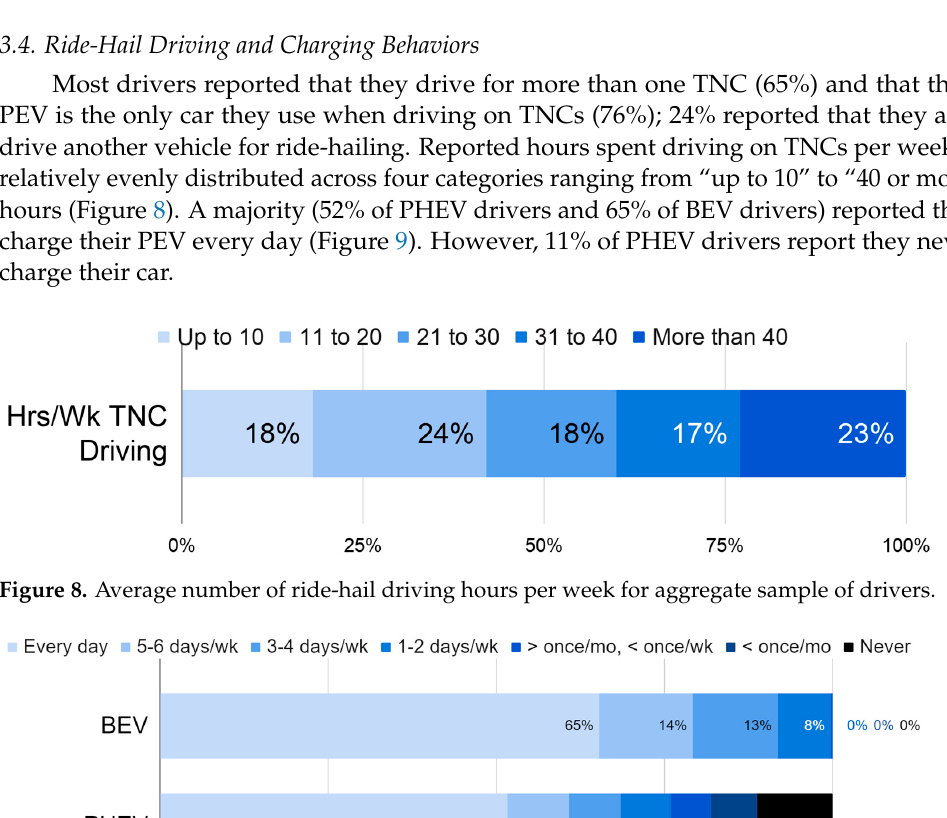
Figure 7. Commitment to PEV relative to commitment to ride-hailing job.